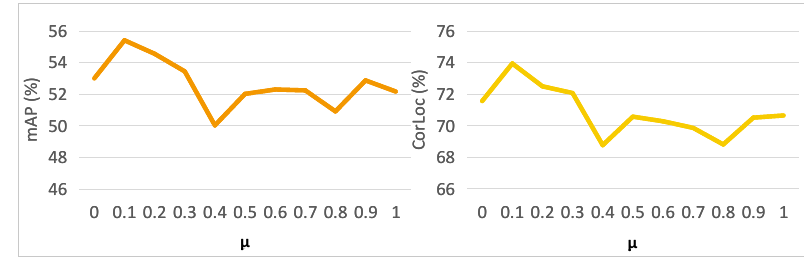
Figure 4. The effect of combination coefficient µ .